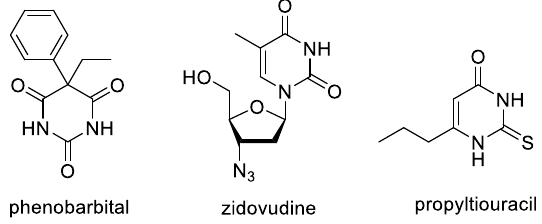
Figure 1. Pyrimidine containing drugs.